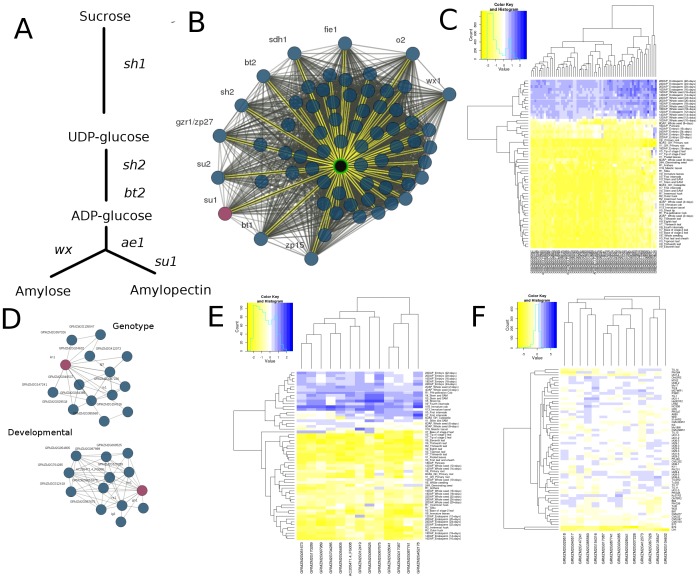
COB Use cases.COB was queried for su1 which is known to be involved with the starch synthesis and sugar metabolism pathway (A). (B) shows the 66 highest co-expressed genes with su1 including many genes already known to be involved with starch synthesis. Examining tissue expression patterns (C) shows that genes in the network are over expressed in whole seed and endosperm. (D) KN1 was queried in both networks and recovered other known homeobox genes (lg3, rs1, gn1). (E) Patterns of gene expression show that these networks are driven by expression in varying stages of embryo development as well as the SAM and shoot tip. (F) Patterns of expression among genes within the KN1 network among diverse maize genotypes.